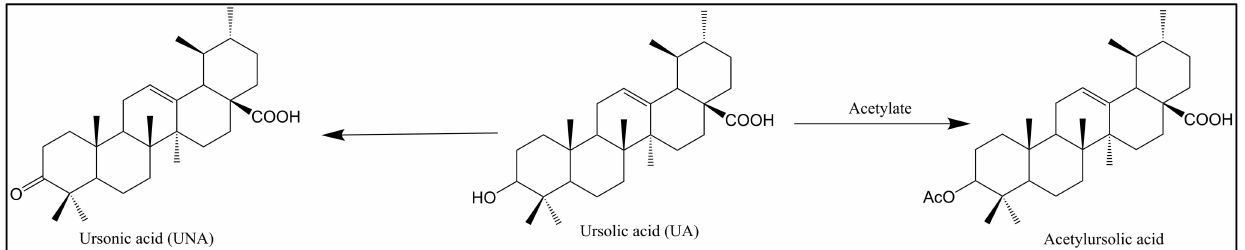
Figure 3. Chemical structures of glycyrrhizic acid (GL) and glycyrrhetinic acid (GA).